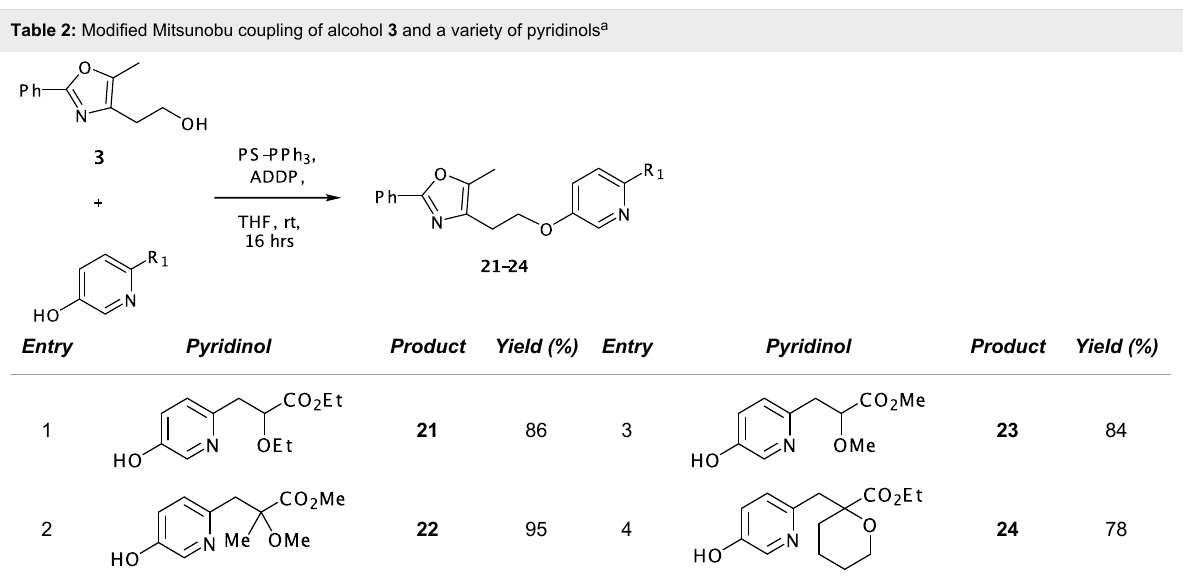
Table 2: Modified Mitsunobu coupling of alcohol 3 and a variety of pyridinols a